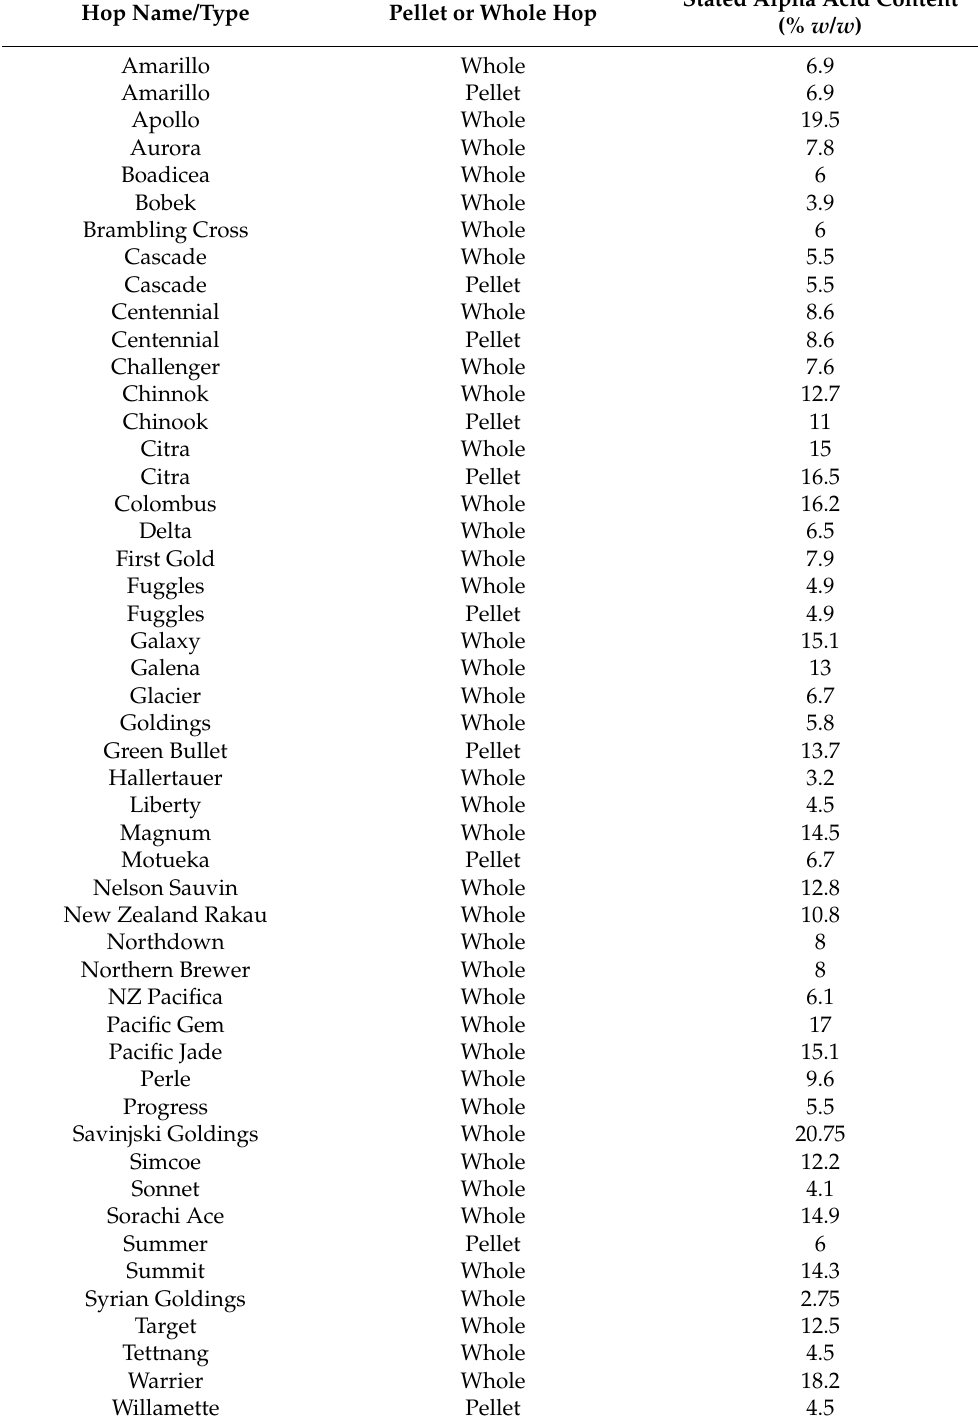
Table 1. The hop variants employed in this study with stated alpha acid content (as determined by supplier). Hop material was supplied either as whole hops or pelleted hops under vacuum and stored at 3 ◦ C until